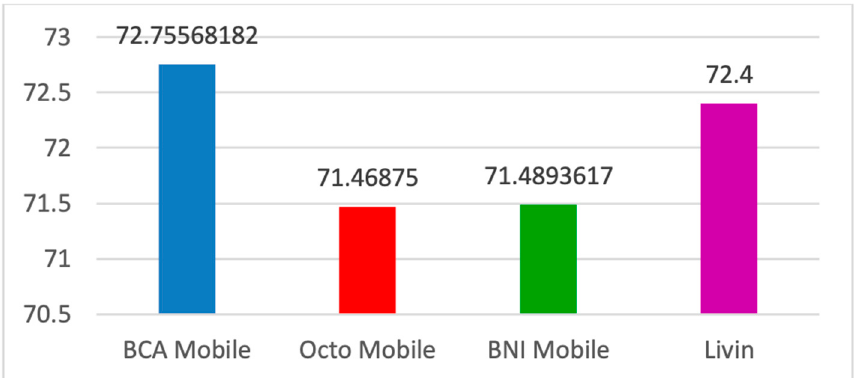
Figure 6. Results of usability measurement using SUS.